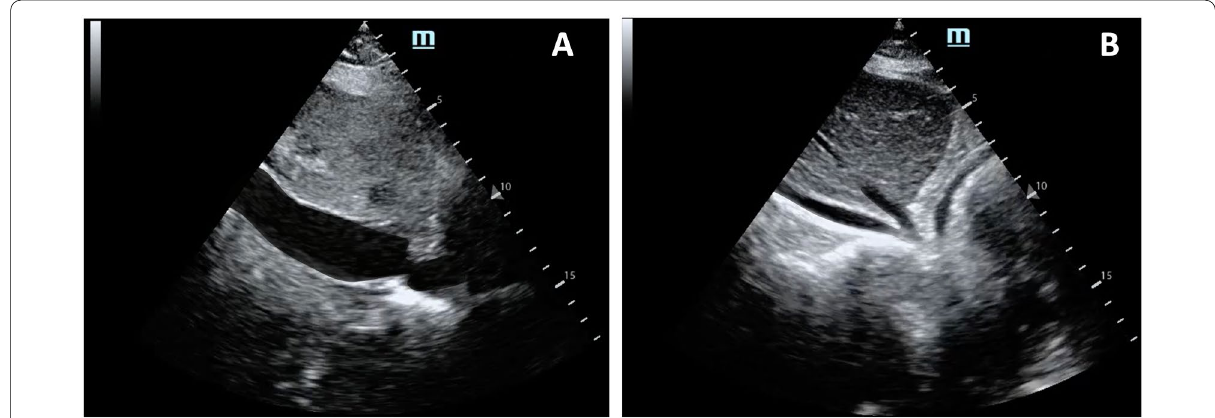
Fig. 3 IVC view: A. Dilated (Video 06), B. Flattened